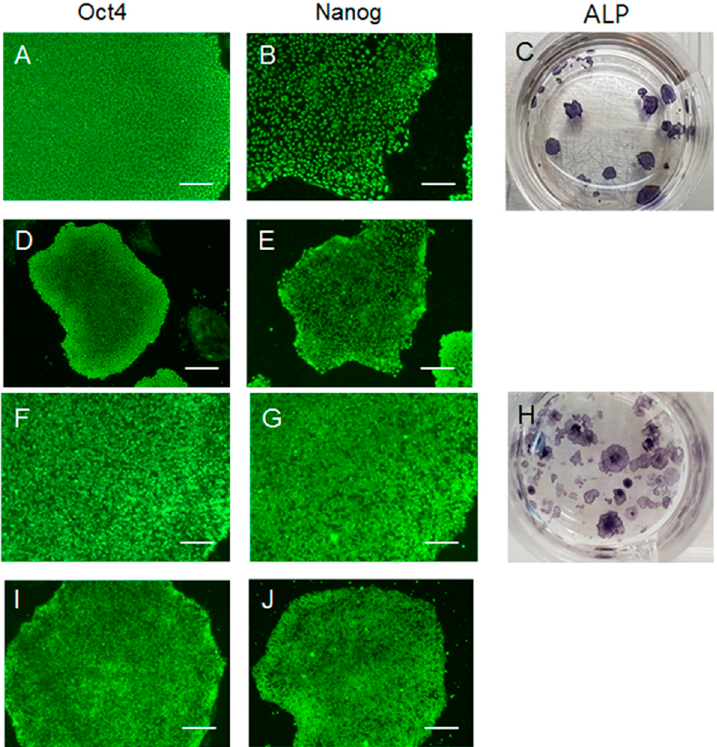
Figure 3. Immunofluorescent staining of H9 hESCs after ten passages cultured in homemade E8 medium containing either hFGF-2 ( A – E ) or hDJ-1 ( F – J ) stained with pluripotency marker Oct4 ( A , D , F , I ) and Nanog ( B,E , G , J ). ALP was stained in H9 hESCs after ten passages cultured in home- made E8 medium containing hFGF-2 ( C ) or hDJ-1 (H). Scale bars indicate 100 µm ( A , B , F , G ) and 200 µm ( D , E , I , J ).